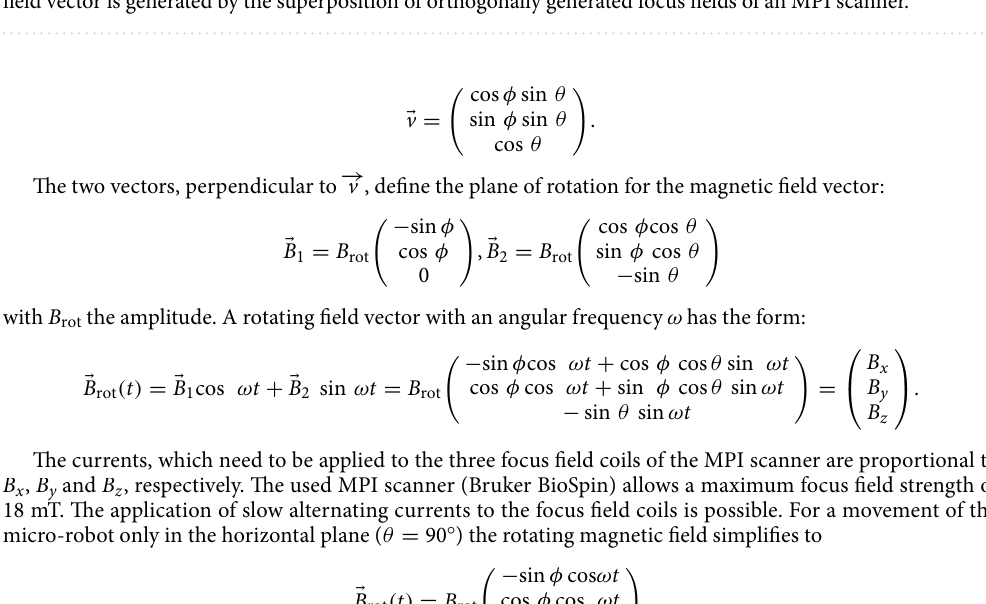
Figure 8. Magnetic actuation with an MPI scanner by using rotating focus fields. The resulting field vector −→ B rot ( t ) needs to rotate in the plane perpendicular to the direction of movement −→ v of the micro-robot. Such a field vector is generated by the superposition of orthogonally generated focus fields of an MPI